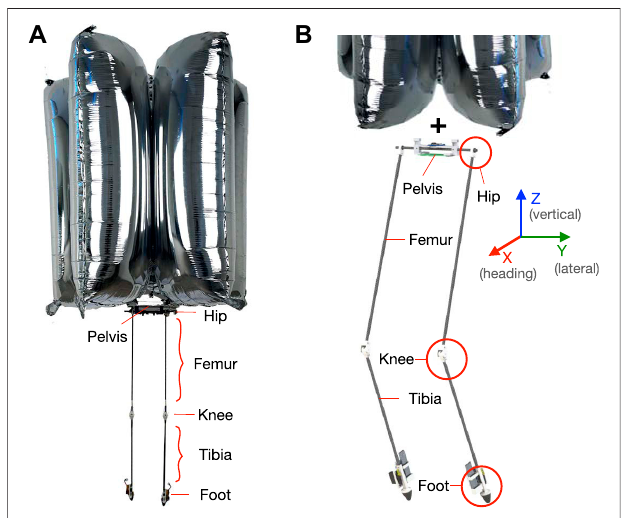
FIGURE 1 | The overall design of BALLU and the name of each